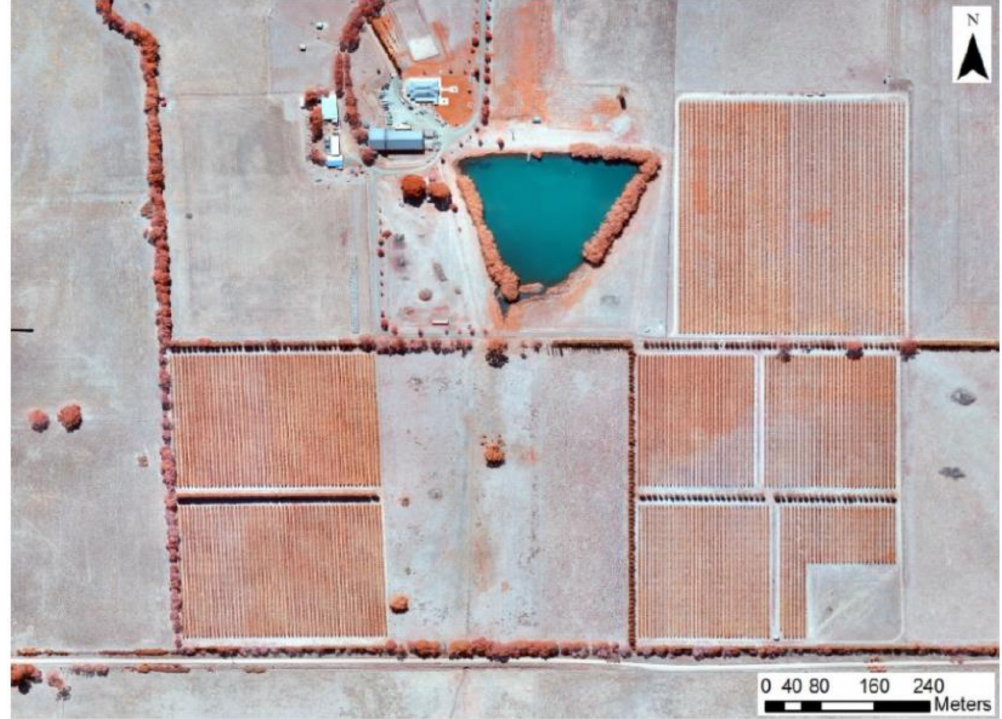
Figure 1. Aerial image of the study area obtained using an unmanned aerial vehicle (UAV) in the 2015–2016 growing season from a total area planted of 42